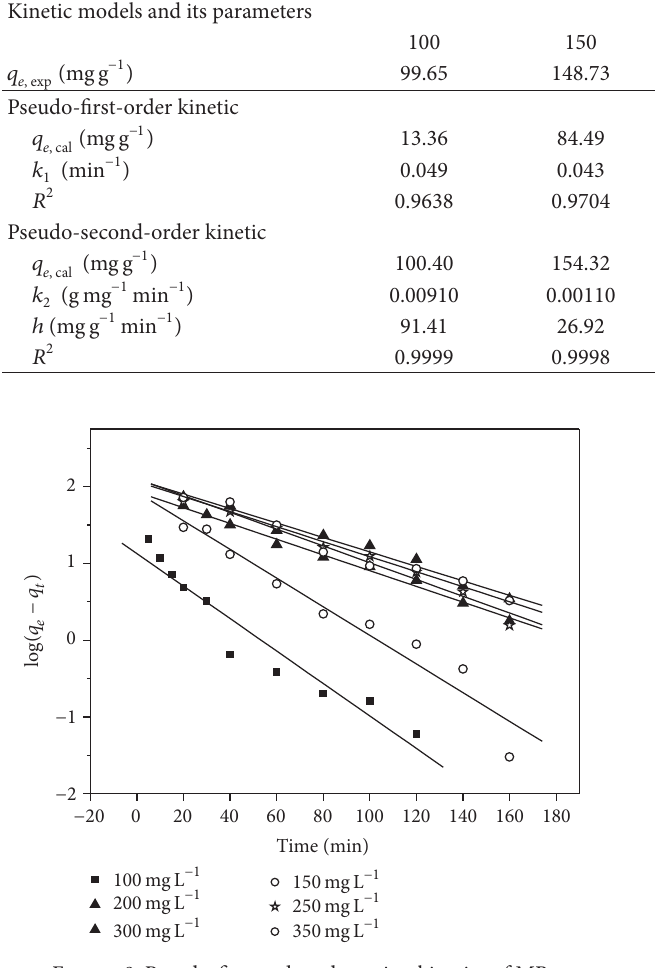
F 8: Pseudo-�rst-order adsorption kinetics of MB. F 9: Pseudo-second-order adsorption kinetics of